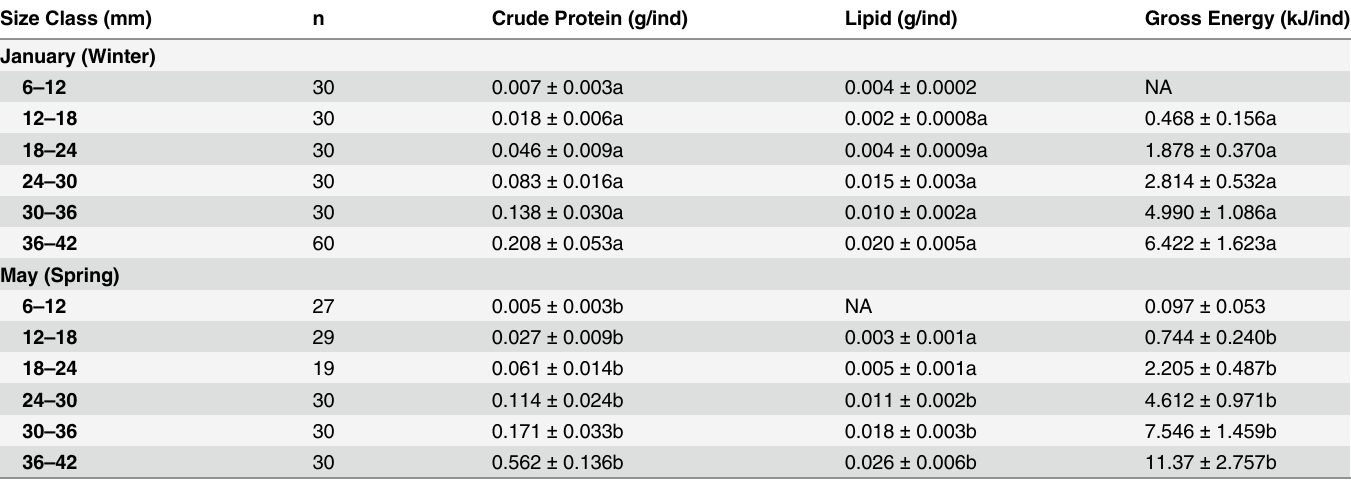
Table 1. The mean amounts ( ± 1 SD) of crude protein (g DM/individual), lipid (g DM/individual), and gross energy (kJ/individual) found for each size class (6 – 12, 12 – 18, 18 – 24, 24 – 30, 30 – 36, 36 – 42 mm) of Ischadium recurvum collected from the Chesapeake Bay in January and May 2007. Size Class (mm)